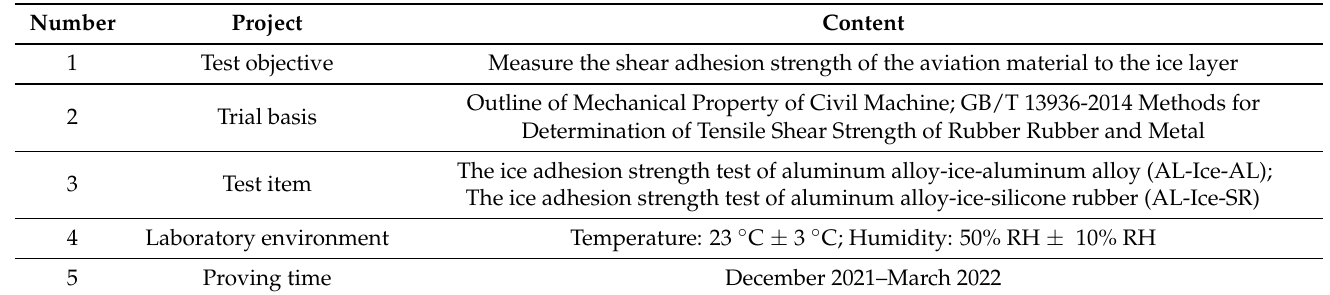
Table 1. Basic information of